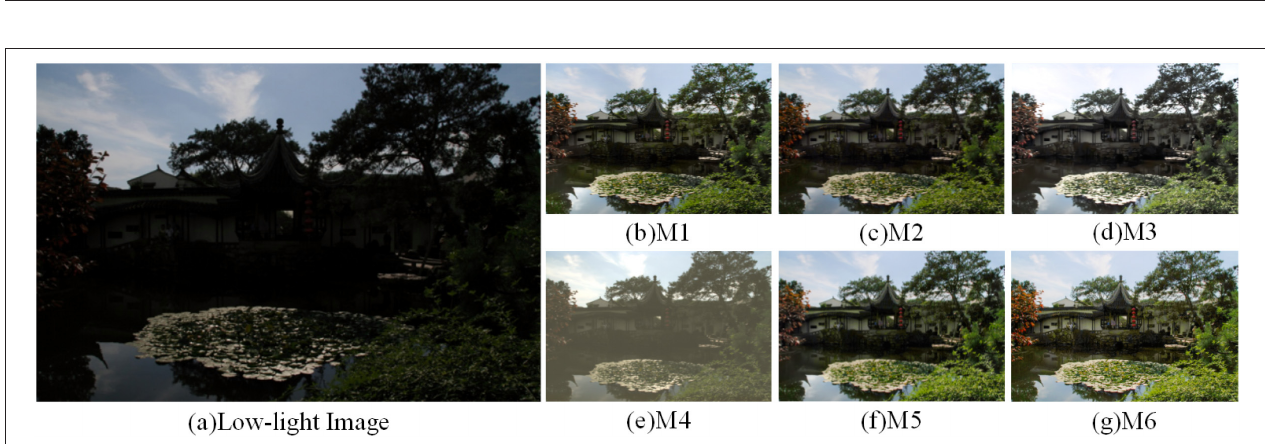
Frontiers in Neurorobotics |